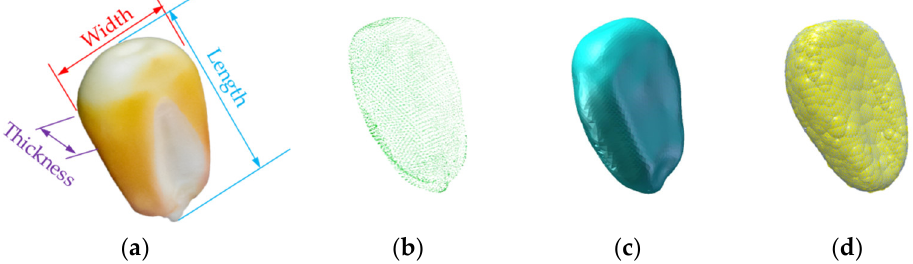
Figure 1. The corn grain of “Demeiya No. 1”: ( a ) corn grain prototype; ( b ) point cloud map; ( c ) 3D scanning model; ( d ) discrete element model.